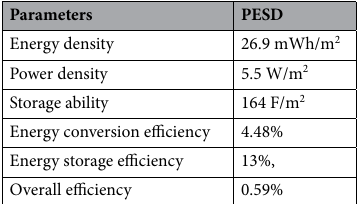
Table 1. Tabulated presentation of device